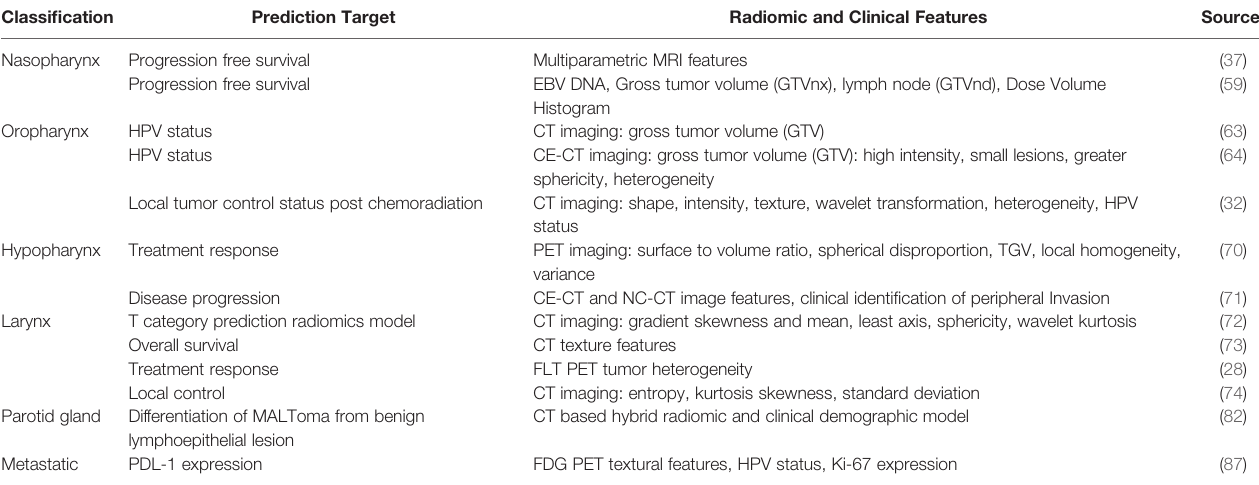
TABLE 1 | Summary of radiomic applications in head and